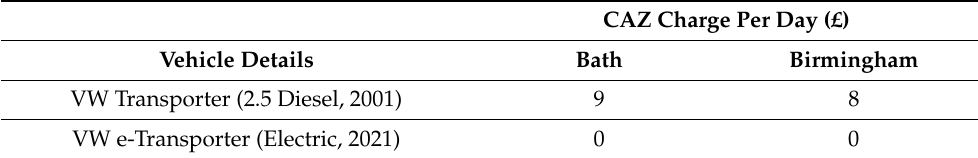
Table 3. Table highlighting the daily costs for different vehicle models in CAZs